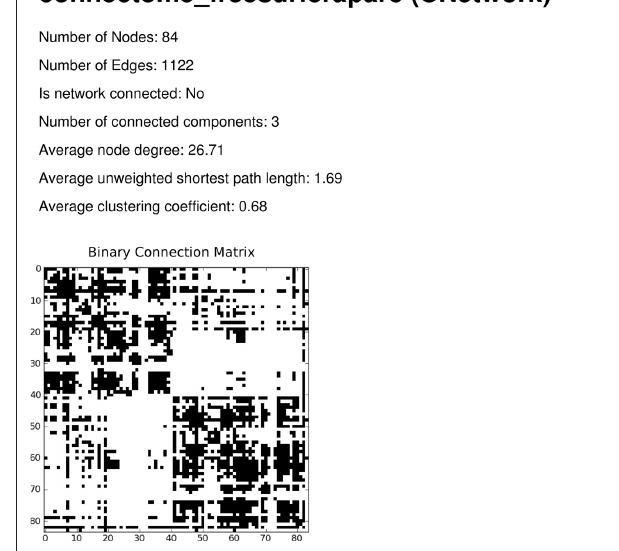
Figure 11 | Network PDF report. Reports can be automatically generated using the Code Oracle “Network Report.” The layout and report content can be adapted and extended with required